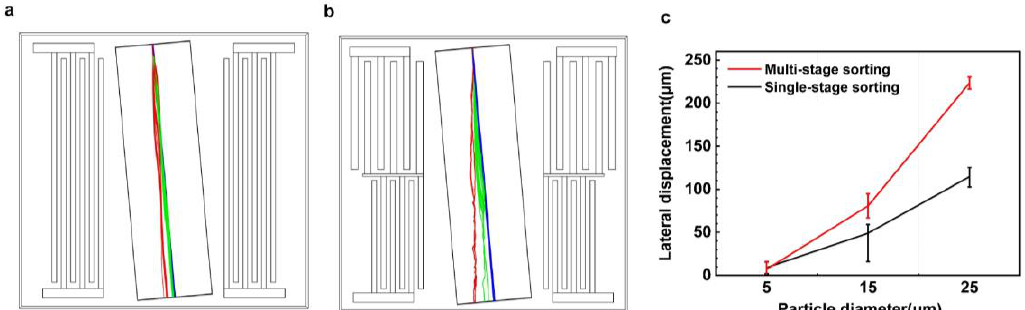
Figure 11. Comparison of the trajectories of sorting particles with three different particle sizes using a single-stage ( a ) and multi-stage sorting device ( b ); the lateral displacement summary of the particles under the single-stage and multi-stage SAW device ( c ).